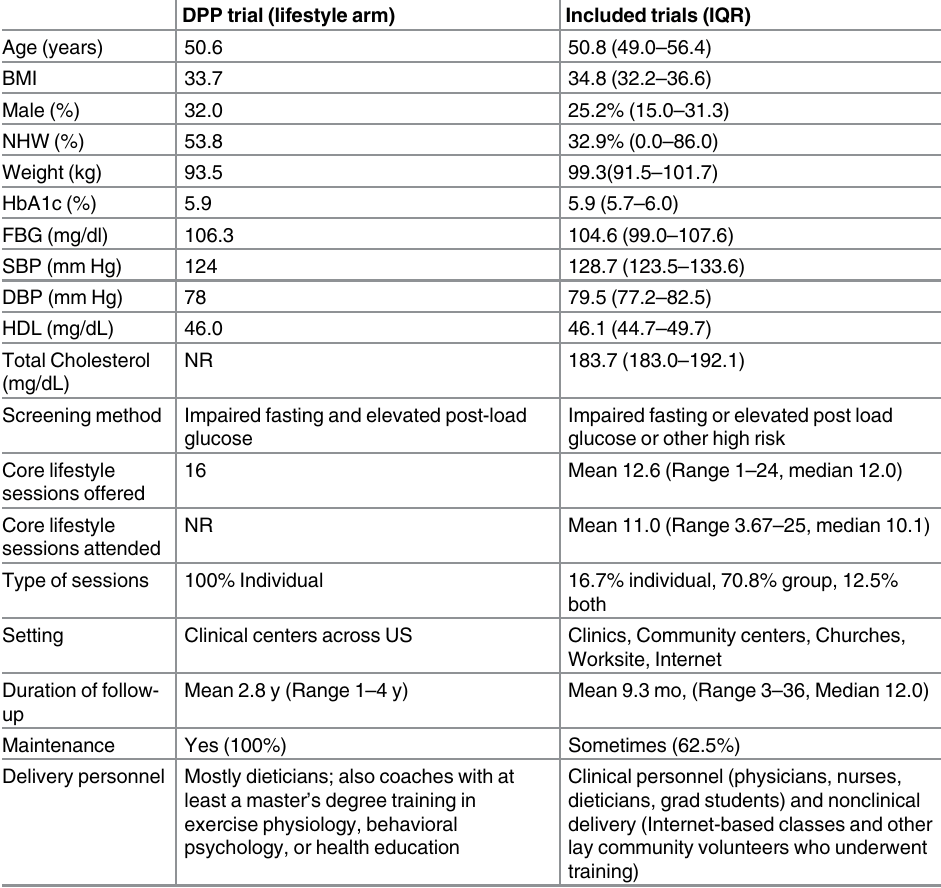
Table 1. Baseline characteristics of trials (aggregate) versus